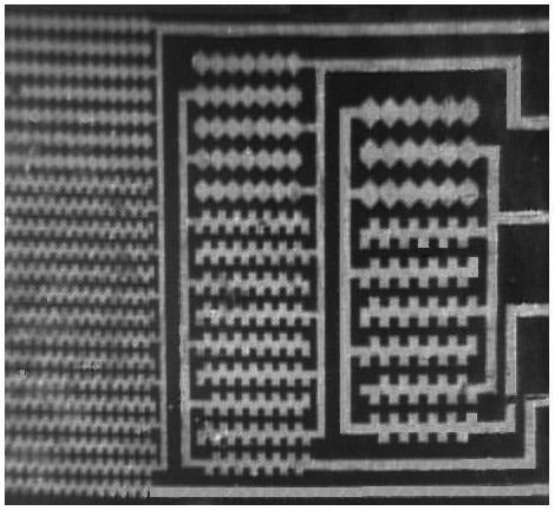
Fig. 6 – Platinum microstructures containing classical and shifted in- terdigitated castellated, as well as saw-teeth electrode arrays. Magni- fication × 50.